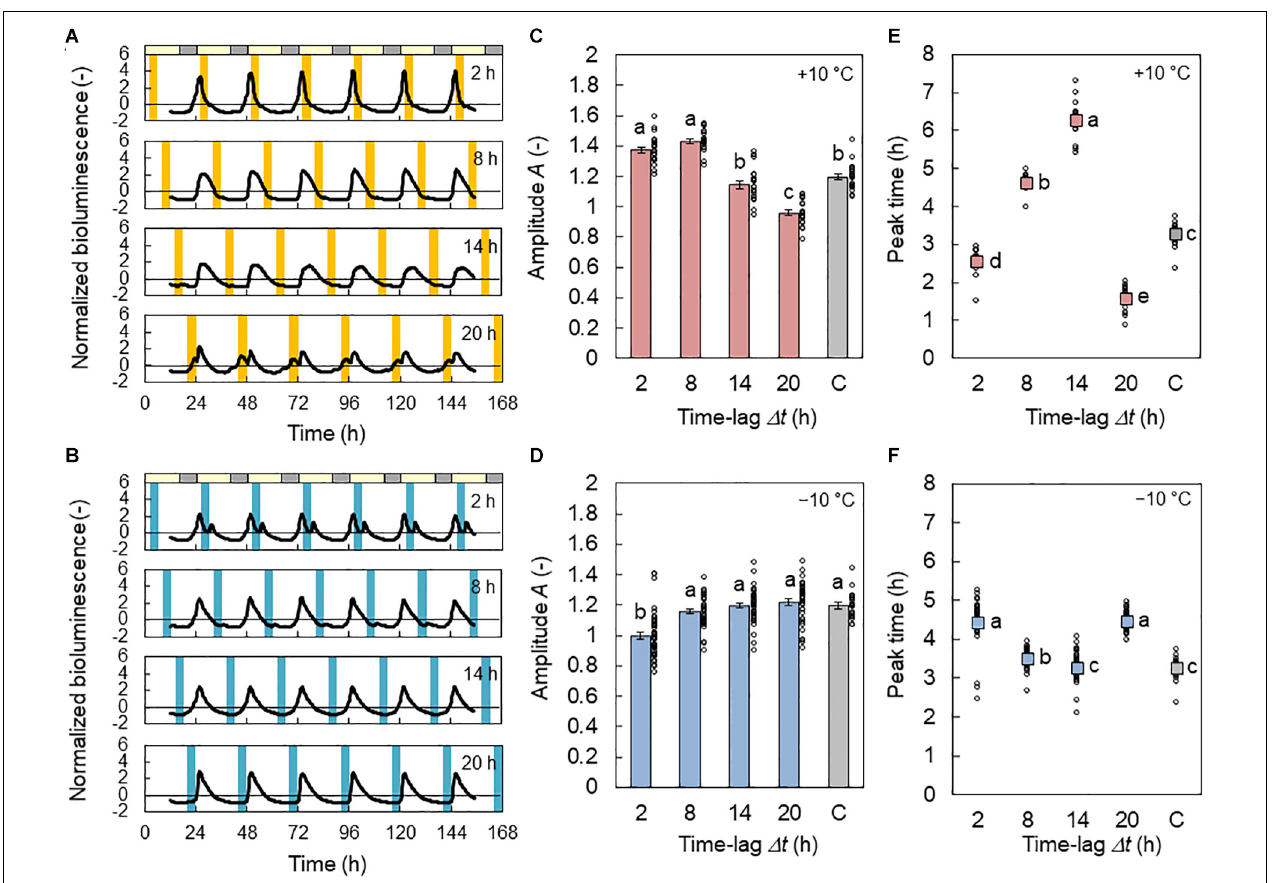
FIGURE 2 | Effect of time lag on the CCA1 rhythm in conditions of L/D = 16/8 h and 4 h ± 10 ◦ C cycles for the in-phase initial conditions. (A,B) Normalized bioluminescence of CCA1 :: LUC in +10 ◦ C (A) and − 10 ◦ C (B) conditions. (C,D) Amplitude A of the bioluminescence oscillation in +10 ◦ C (C) and − 10 ◦ C (D) conditions (mean ± SEM, n = 20 individuals in +10 ◦ C, 40 in − 10 ◦ C, and 20 in the control condition). The control condition is labeled C. The circles indicate the individual data points. Different letters indicate significant differences for each panel (Tukey–Kramer test, p < 0.05). (E,F) Peak time in +10 ◦ C (E) and − 10 ◦ C (F) conditions (circular mean, n = 20 individuals in +10 ◦ C, 40 in − 10 ◦ C, and 20 in the control condition). The circles indicate the individual data. Different letters indicate significant differences for each panel (Watson–Williams test with Bonferroni correction, p <